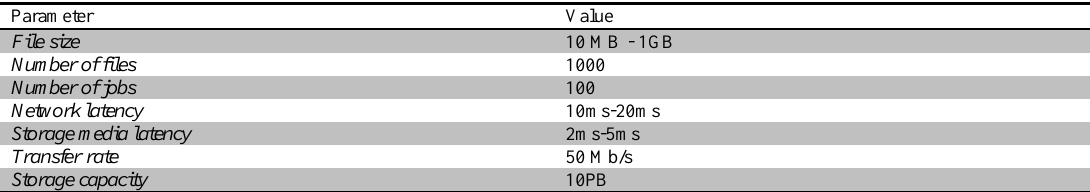
Table 1. Parameters used in